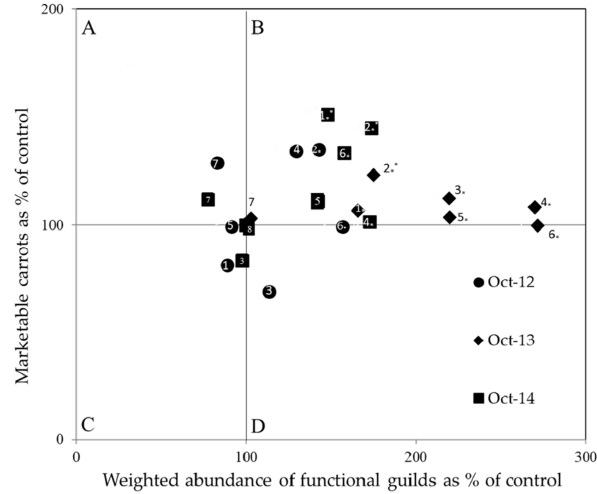
Figure 5. Integrated Production Efficiency (IPE) of amending sandy clay loam soil with either animal (AC) or plant (PC) based compost applied at 135, 203 or 270 kg N/ha on marketable carrot ( y -axis) and weighted abundance of functional guilds (WAFG, x -axis) of nematodes at harvest in October 2012 (Oct-12), 2013 (Oct-13) and 2014 (Oct-14) growing seasons fitted to the IPE model. Numbers 1–3 refer PC at a rate of 135, 203 and 270 kg N/ha, respectively and 4–6 refer AC at a rate 135, 203 and 270 kg N/ha, respectively, 7 and 8 refer urea and non-amended check, respectively. * Treatments with subscripts and superscripts asterisks (*) indicate significantly different form 100% for WAFG and marketable carrots, respectively, using one-tailed t-test at α = 0.05. The soil amendment rates and the marketable carrot data presented here are the same as those in Table S3. The WAFG data presented here are the same as those in Table